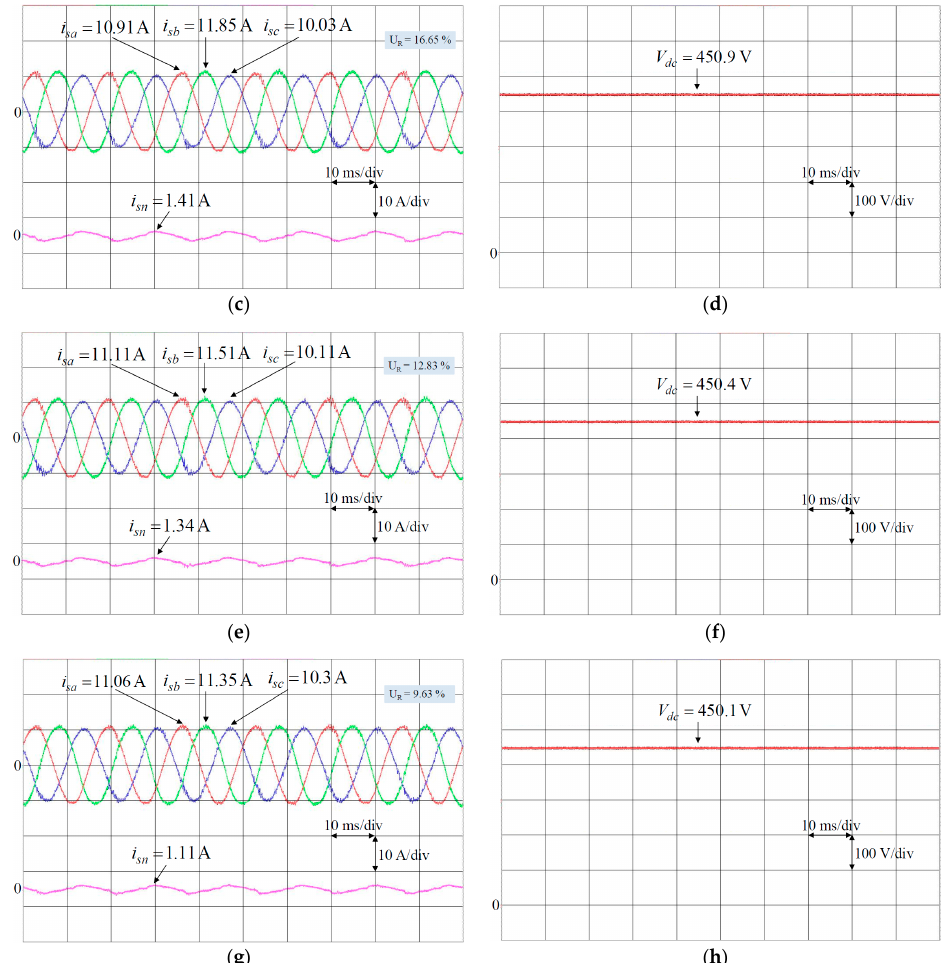
Figure 8. Experimental results at unbalanced load 3 under abnormal grid voltage: ( a ) Response of grid voltage with 0.2 pu voltage dip at load 3; ( b ) Responses of three-phase currents i sa , i sb , i sc and neutral current i sn without using shunt APF; ( c ) Responses of three-phase currents i sa , i sb , i sc and neutral current i sn using PI controlled shunt APF; ( d ) Response of DC-link voltage V dc using PI controlled shunt APF; ( e ) Responses of three-phase currents i sa , i sb , i sc and neutral current i sn using PFNN controlled shunt APF; ( f ) Response of DC-link voltage V dc using PFNN controlled shunt APF; ( g ) Responses of three-phase currents i sa , i sb , i sc and neutral current i sn using proposed PPFNN controlled shunt APF; and ( h ) Response of DC-link voltage V dc using proposed PPFNN controlled shunt APF.